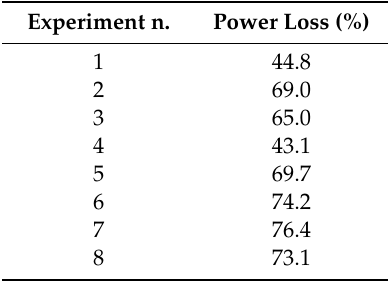
Table 6. Vector y containing the value of power loss measured for each mix. Experiment Table 6. Vector 𝑦(cid:3364) containing the value of power loss measured for each mix. Experiment n.